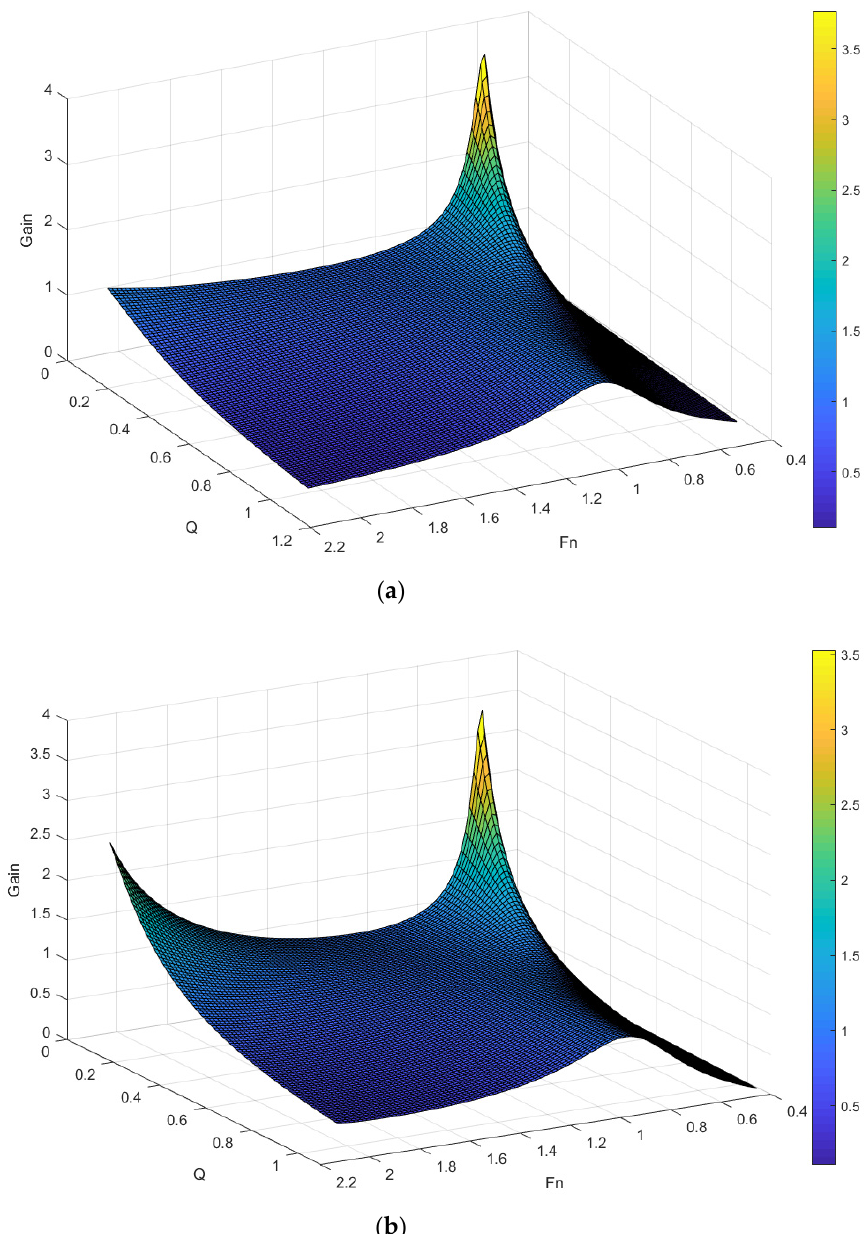
Figure 3. LLC resonant converter voltage gain with effect ( a ) 𝐶 (cid:3041) =0.1, ( b ) 𝐶 (cid:3041) =0.5